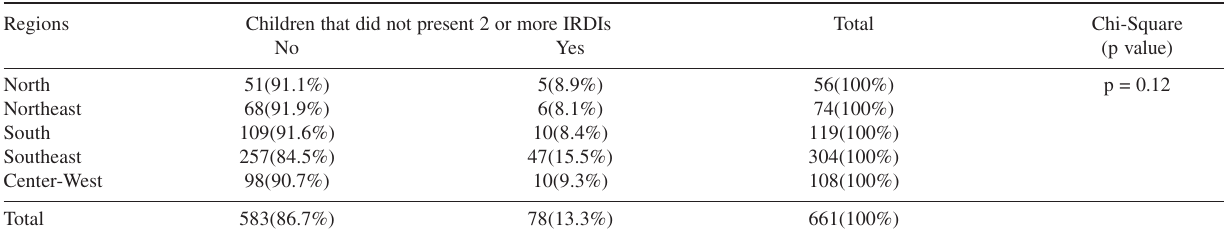
Table 5 - Each region was compared with the entire sample. P value was obtained. Regions